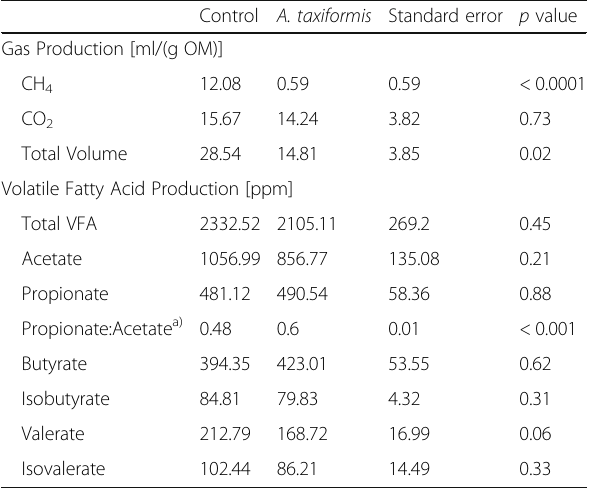
Table 2 Effects of A. taxiformis on total gas production and total volatile fatty acid production